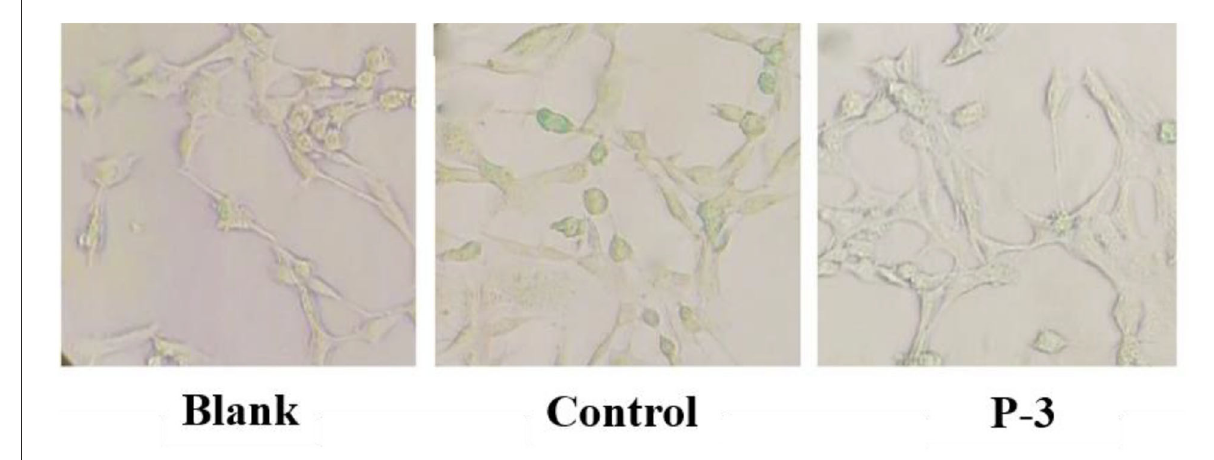
FIGURE7 Optical microscope image of cell senescence-associated β -galactosidase staining of 1.4mM H 2 O 2 -induced HSF cells after treatment with 0.6 mg/ml P-3 for 24h. The HSF cells only treated by DMEM for 24h were used as blank. Control was treated with 1.4mM H 2 O 2 for